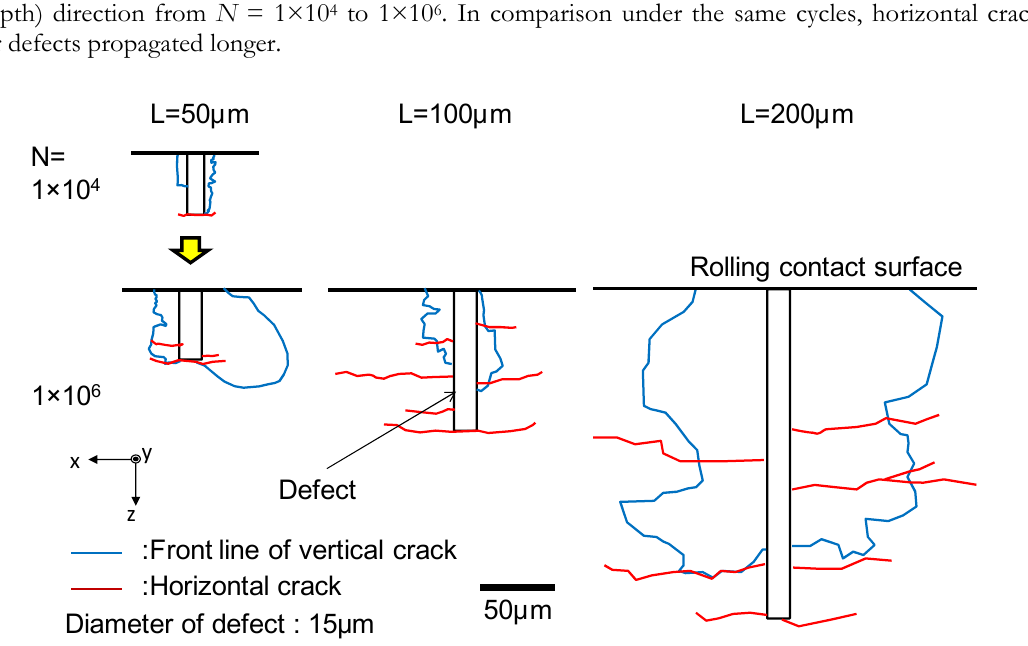
Figure 4: Comparison of crack shape and size between different number of cycles and defect